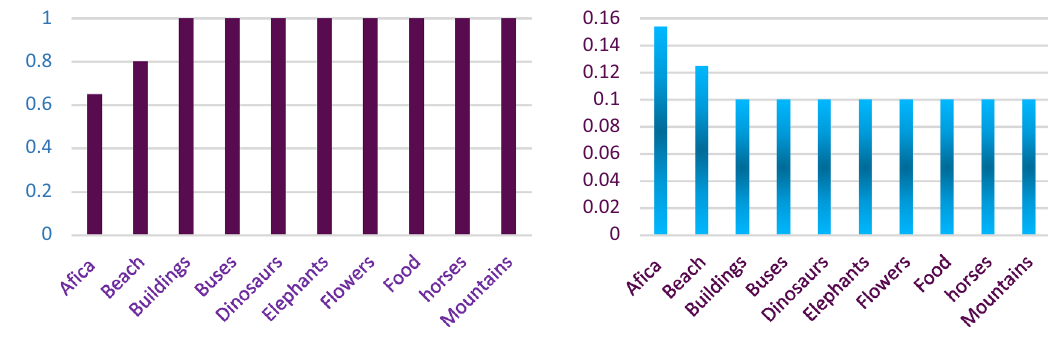
Fig. 18 a Average precision Corel 1000 image dataset. b Average recall Corel 1000 image dataset